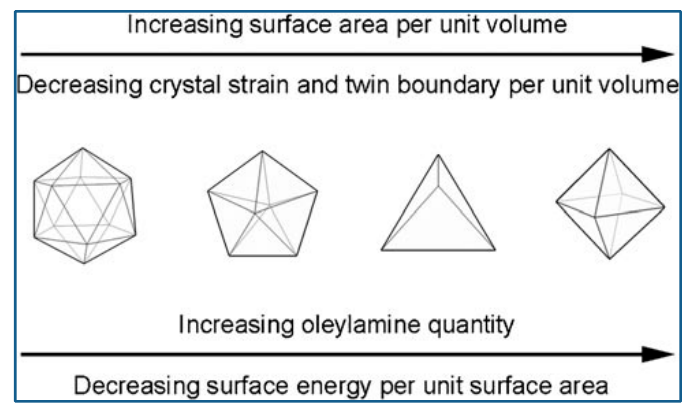
Figure 5. Schematic illustration of shape evolution mediated by OAm. Reproduced with permission [73]. Copyright 2009, American Chemical Society.